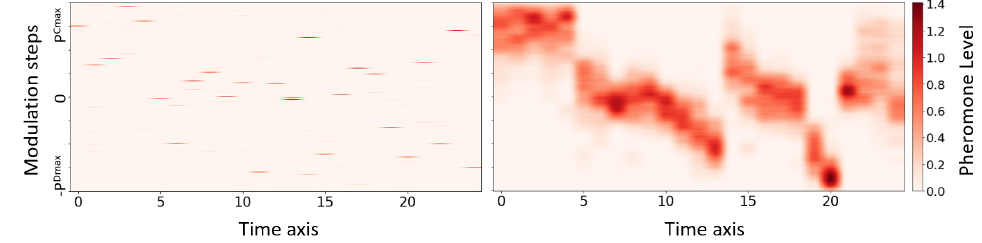
Figure 14. Pheromone matrix ( left ). Pheromone matrix applied cross-correlation ( right ).